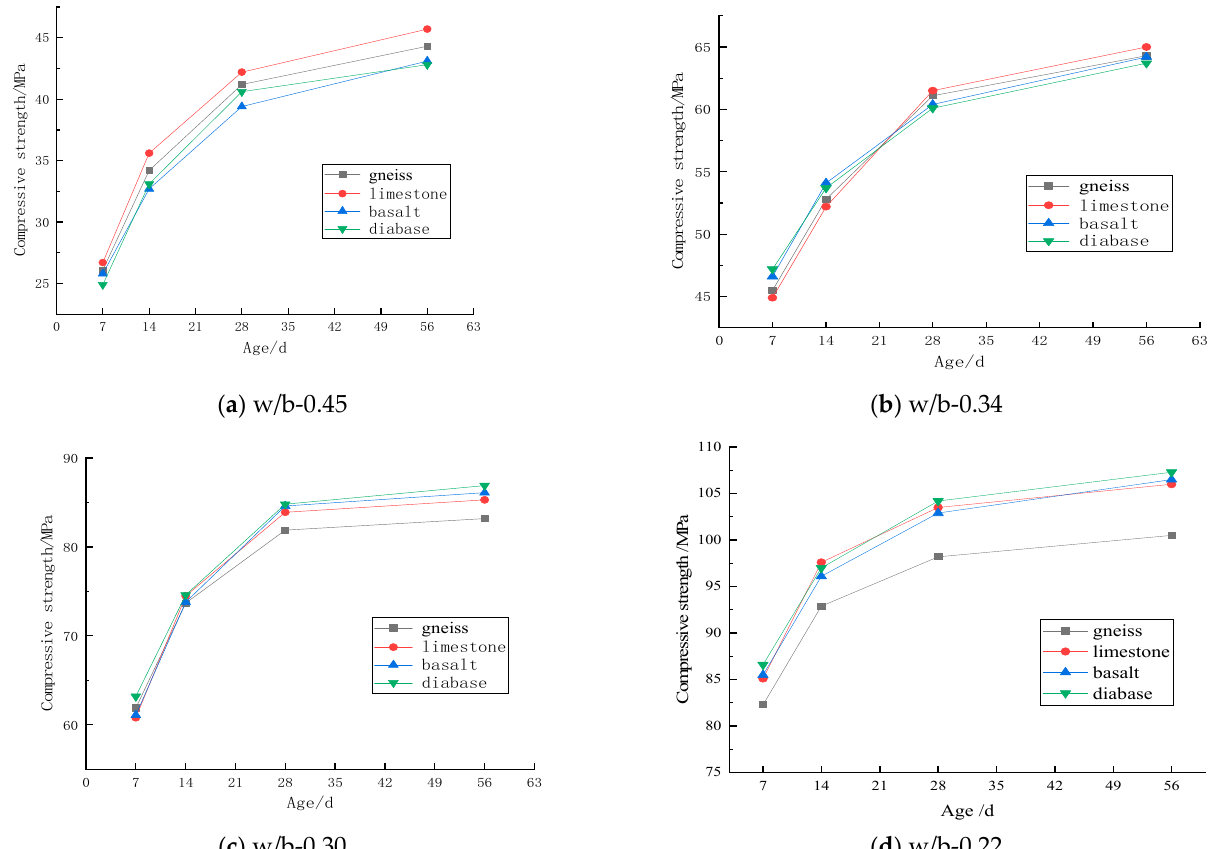
Figure 5. The compressive strength of concrete with different types of coarse aggregate:( a ) water-binder ratio of 0.45; ( b ) water-binder ratio of 0.34; ( c ) water-binder ratio of 0.30 and ( d ) water-binder ratio of 0.22.